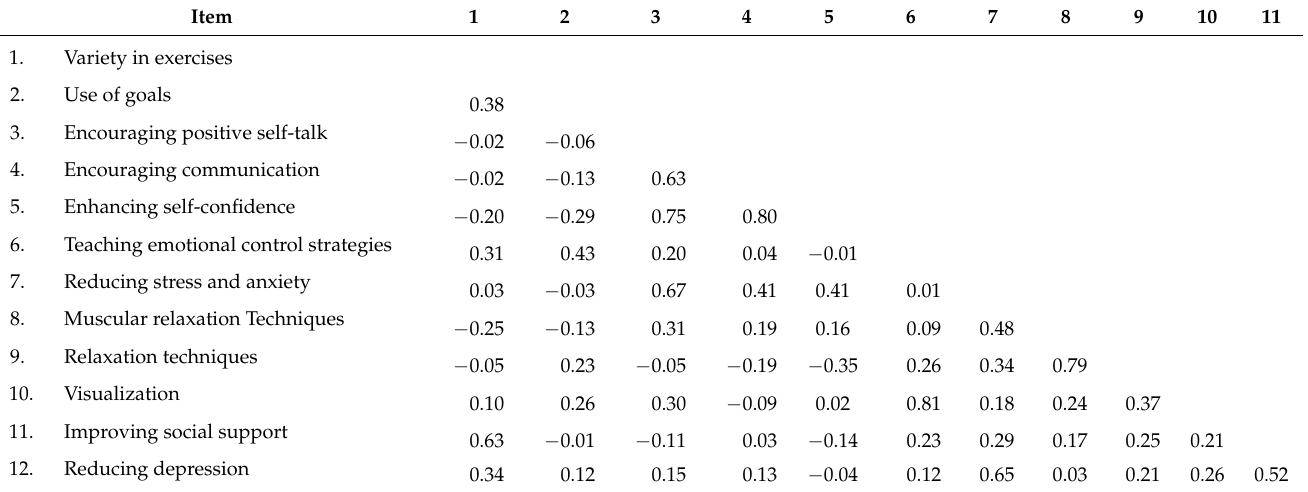
Table 3. Spearman correlations among responses to Physical Therapist Behavioral Checklist